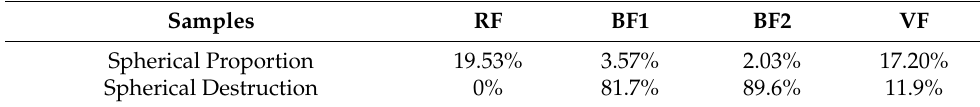
Figure 4. Accumulating area of different fly ash. ( a ) RF (Raw fly ash). ( b ) BF1 (Grinding for 1 h in ball mill). ( c ) BF1 (Grinding for 2 h in ball mill). ( d ) VF (Grinding in vertical mill). The spherical destruction calculation of different fly ash is listed in Table 4. Table 4. Spherical destruction in different fly